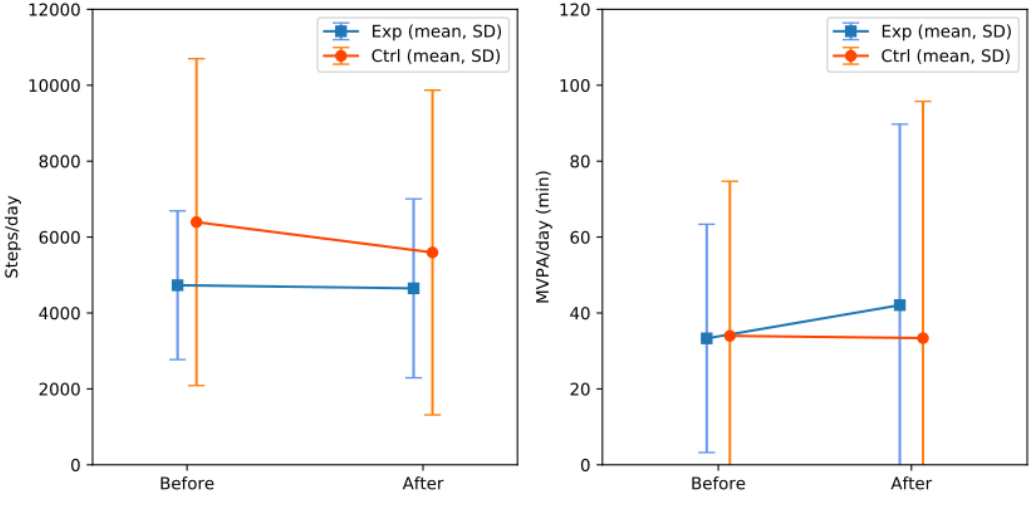
Figure 6. Average steps per day and MVPA per day in each group before and after the game was downloaded. Ctrl: control; Exp: experiment; MVPA: moderate-to-vigorous physical